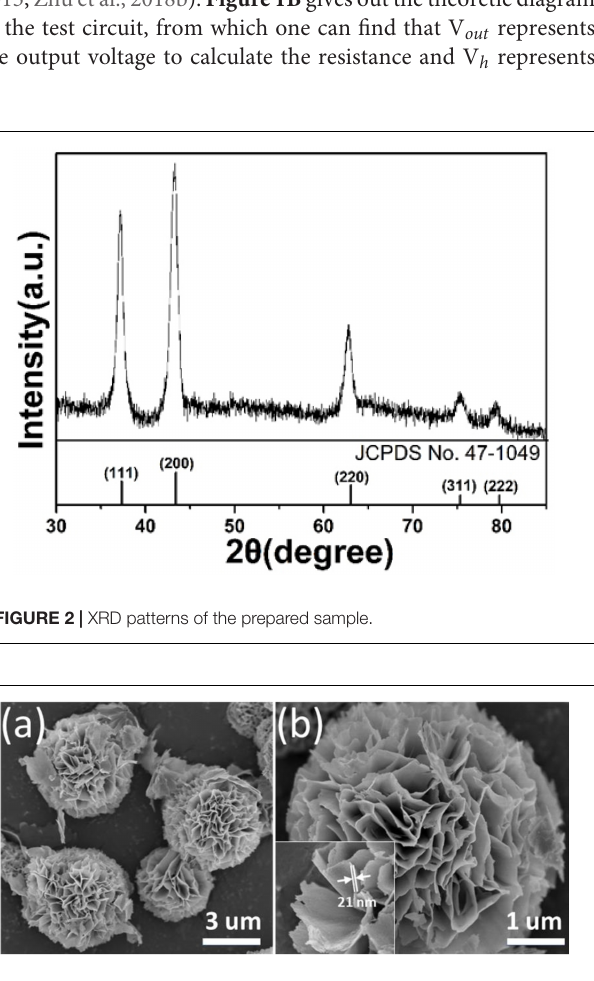
FIGURE 3 | SEM images of the flake-flower microstructure at low (a) and corresponding high (b) magnification.